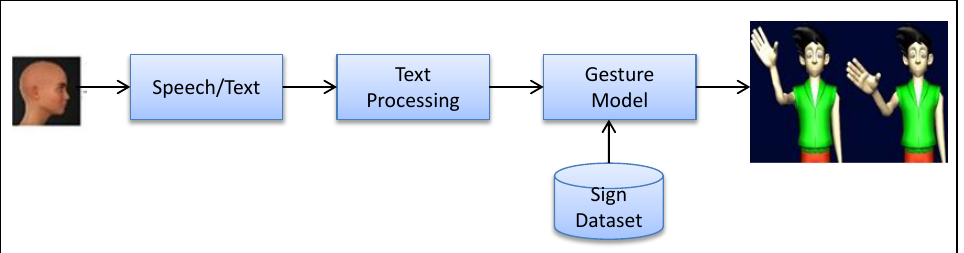
Figure 1. An assistive model for generating sign movements using the 3D avatar from English